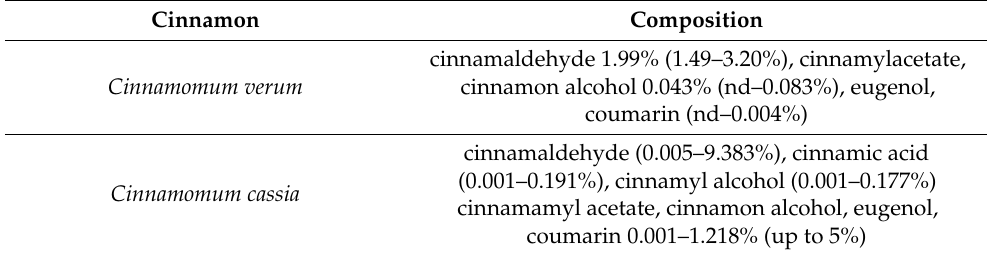
Table 3. Basic composition of the bark of Cinnamomum verum J. Presl and Cinnamomum cassia L.